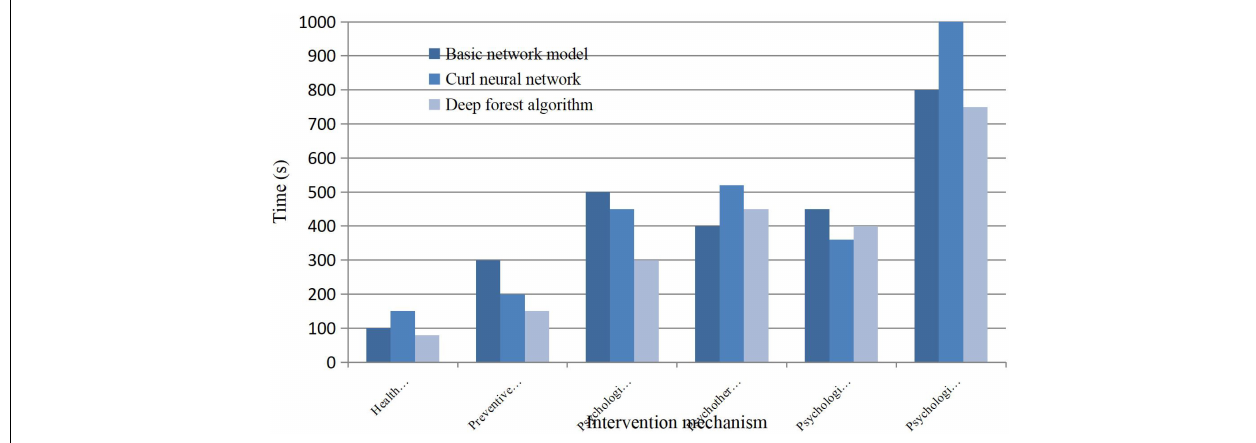
FIGURE 5 | Comparison results of predicted runtime.